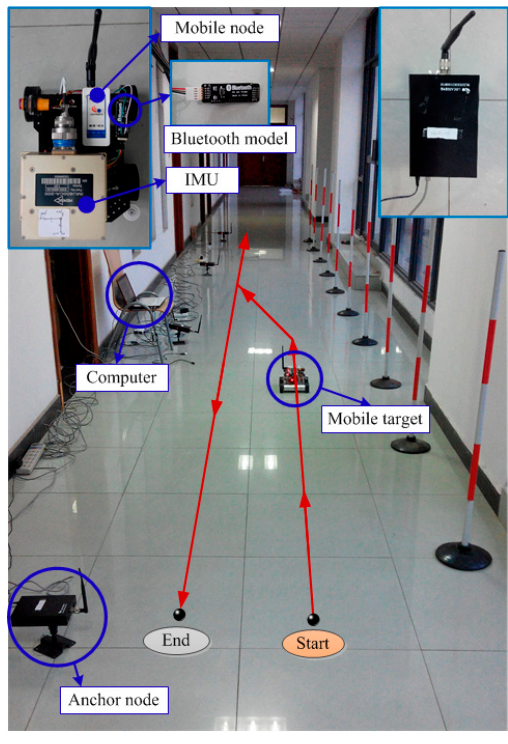
Figure 9. Experimental diagram of integrated positioning system with SINS/WSN.